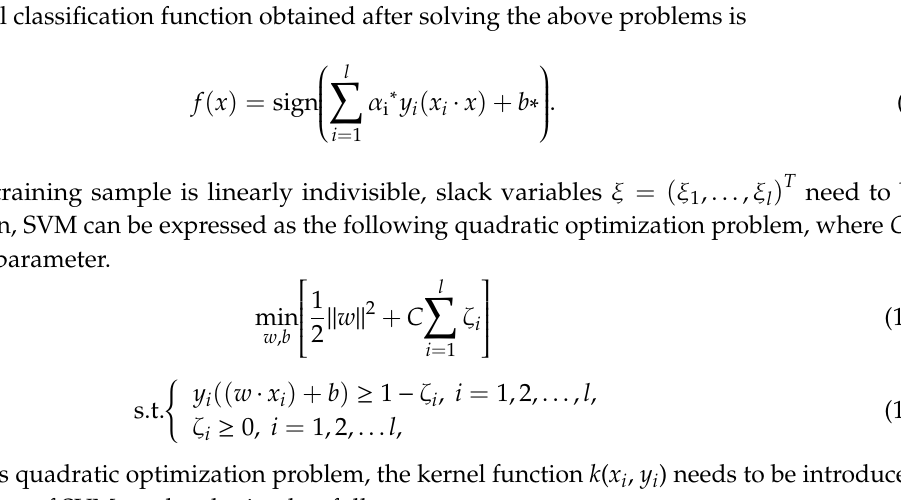
Figure 2. Schematic diagram of support vector machine method.